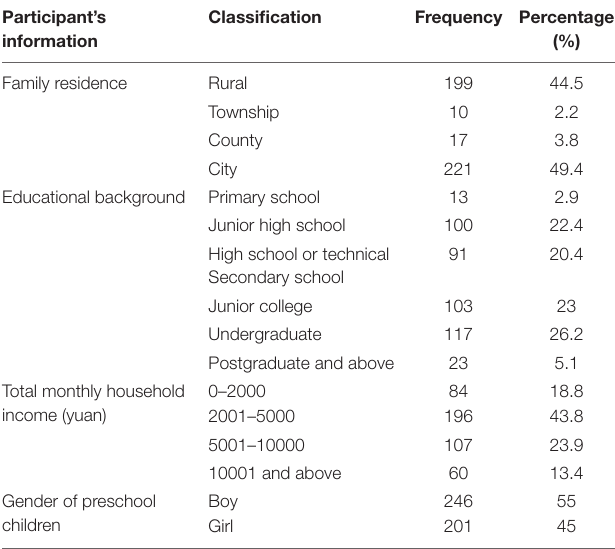
TABLE 1 | Basic participant information in Study 2 ( n =